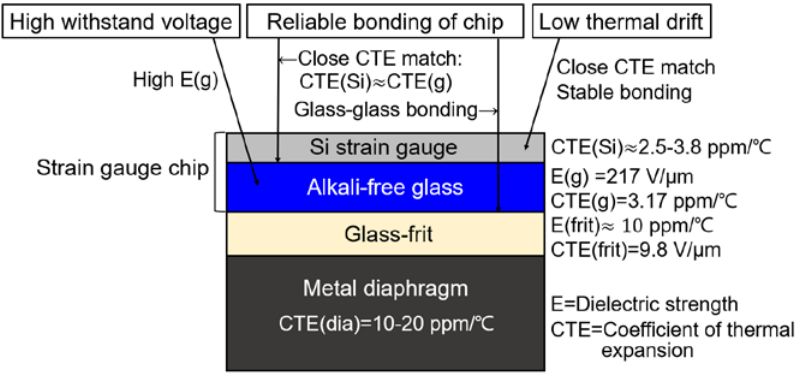
Figure 2. Summary of three main features for Si strain gauge design.